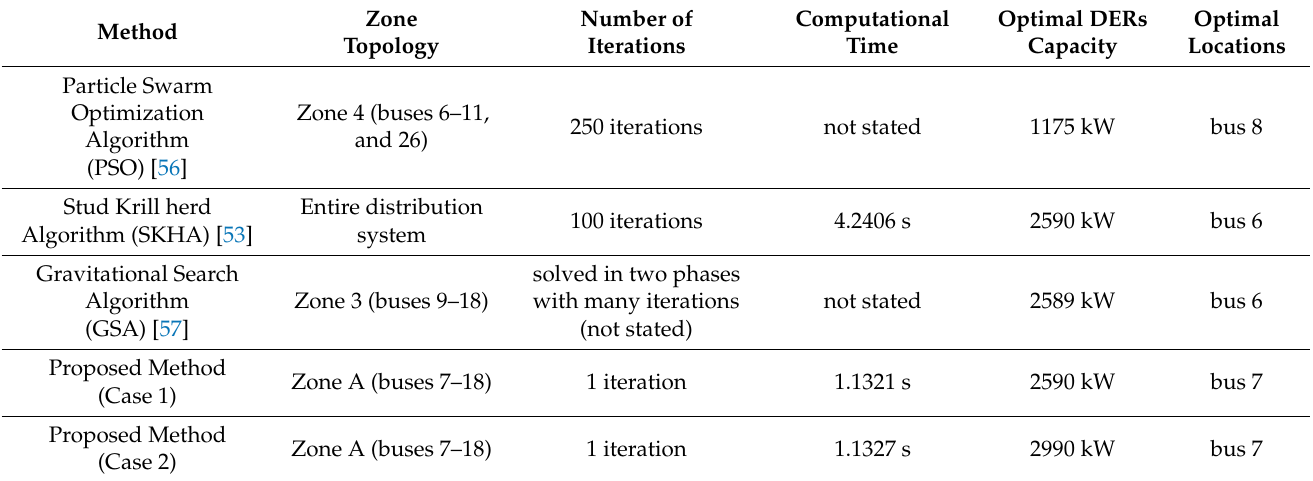
Table 4. Comparison Between the Proposed Method and Other